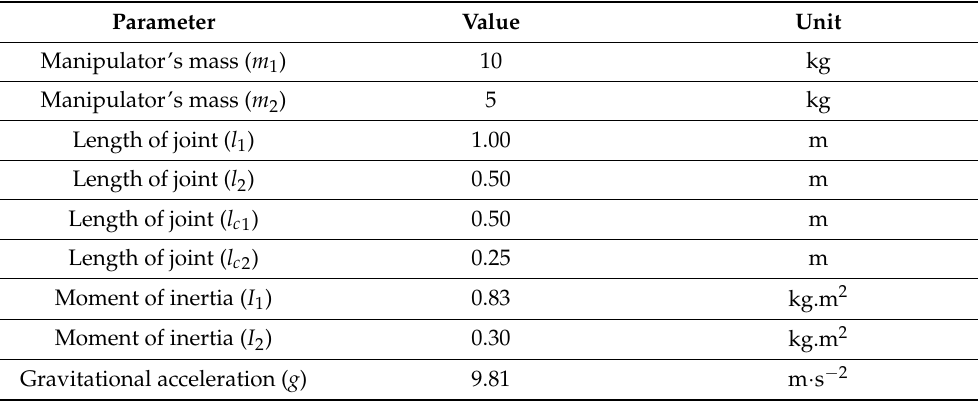
Table 1. Parameters of robotic manipulator.